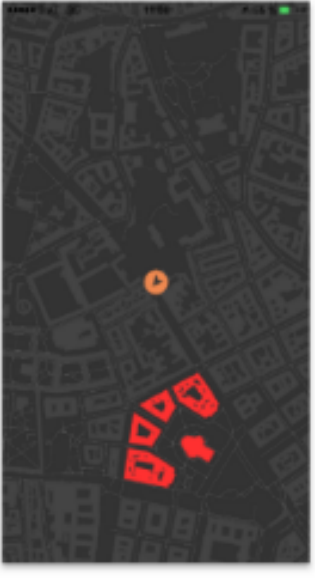
Figure 10. Conquer the city, location-based activity